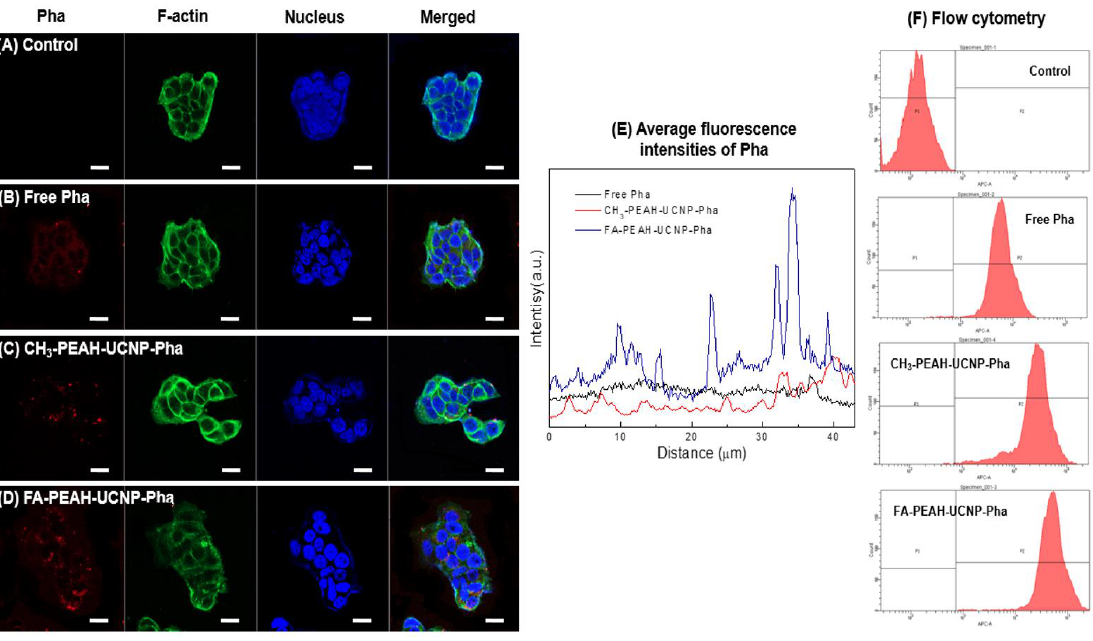
Figure 8. Confocal images of free Pha and FA / CH 3 -PEAH-UCNPs-Pha against MCF7 cells (DAPI (blue color), F-actin (green color), Pha (red color)); ( A ) control, ( B ) free Pha, ( C ) CH 3 -PEAH-UCNPs-Pha, and ( D ) FA-PEAH-UCNPs-Pha, scale bars represent 20 µ m; ( E ) average fluorescence intensities of Pha in the confocal images; ( F ) flow cytometry assay of free Pha, CH 3 -PEAH-UCNPs-Pha and FA-PEAH-UCNPs-Pha in MCF7